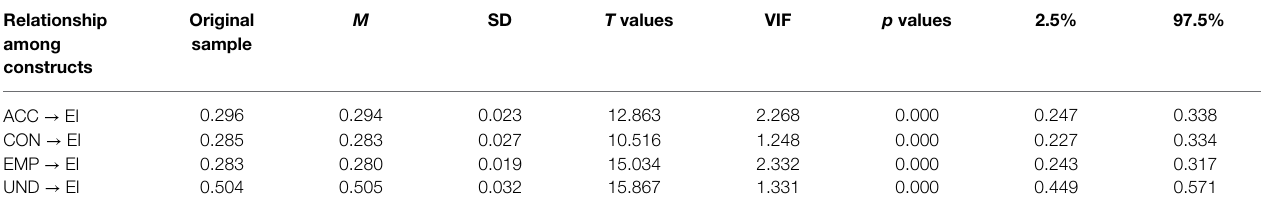
TABLE 3 | Variance inflation factor and outer weight. Relationship among constructs